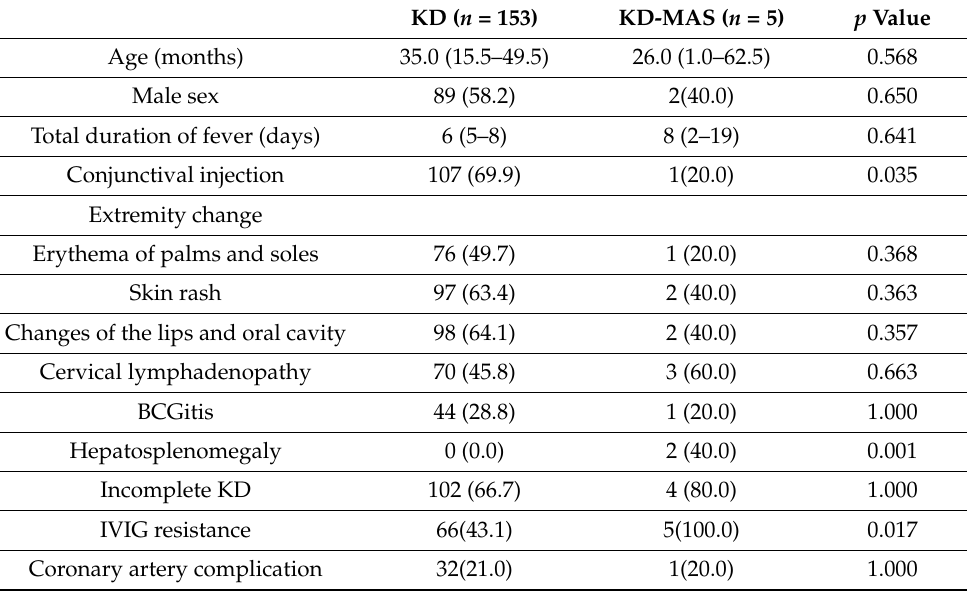
Table 1. Comparison of clinical characteristics between